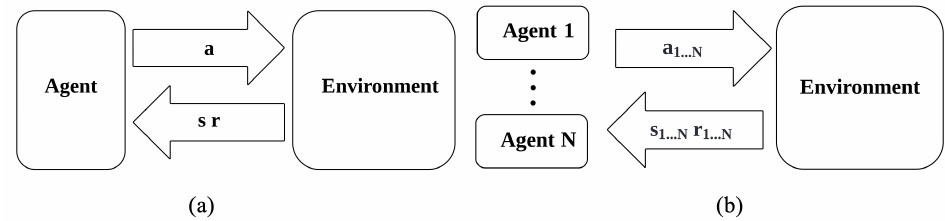
Figure 1. Conceptual diagram: ( a ) Markov decision process and ( b ) Markov game (a—action, s—state,